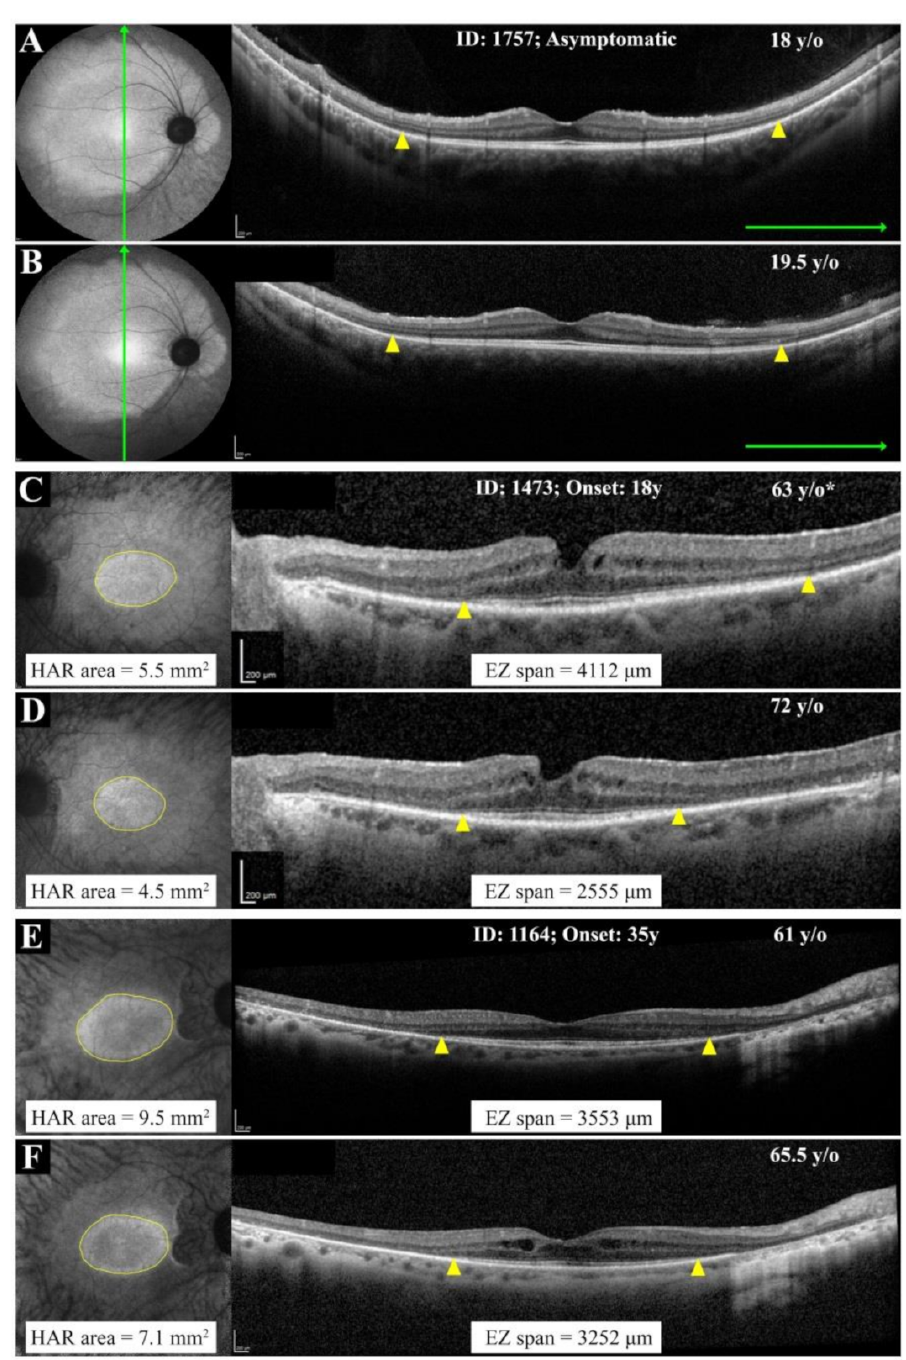
Figure 6. Structural disease progression using near-infrared autofluorescence (NIAF) imaging and spectral-domain optical coherence tomography (SD-OCT) in 3 patients with adult-onset disease. The asymptomatic patient showed stable hyperautofluorescent ring (HAR) and ellipsoid zone (EZ) extent over 1.5 years’ follow up ( A , B ). Since EZ endings were detectable only on vertical widefield SD-OCT and HAR temporal border fell beyond the imaging field, measurements were not reported. In contrast, patients 1473 ( C , D ) and 1164 ( E , F ), both with large deletions, showed variable rates of disease progression on both NIAF and SD-OCT. * The baseline NIAF imaging in patient 1473 was performed at age 69 years. Yellow arrowheads show nasal and temporal EZ